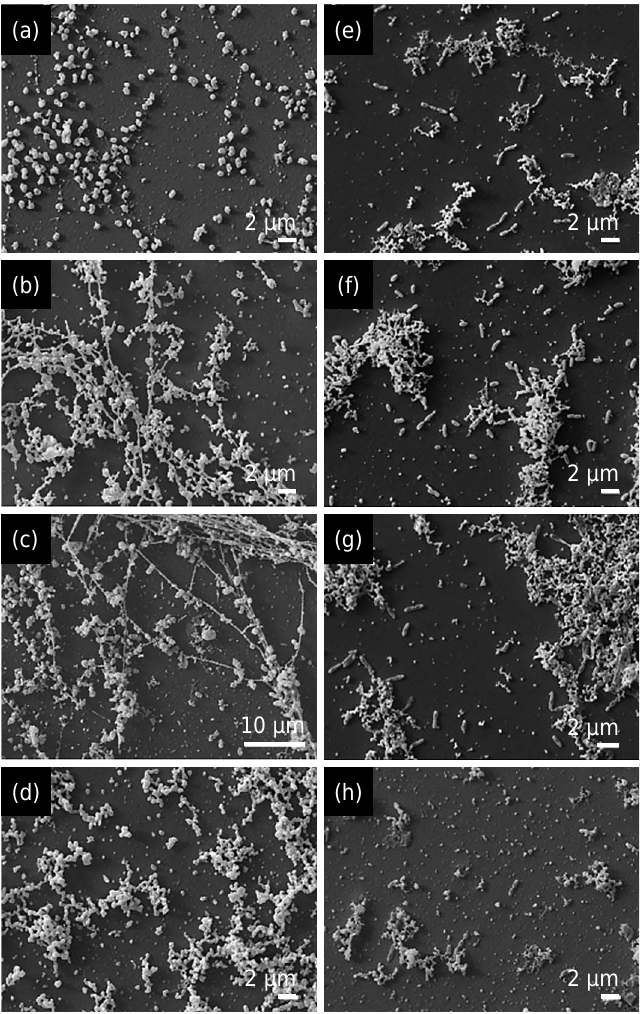
Figure 3. Scanning electron micrograph of the microbial biomass of the strains LMG 19424 T (a, b, c, and d) and UFLA 01-659 (e, f, g, and h) cultured in liquid LB medium in the following treatments: control – absence of metals (a and e), Cd at 1 mmol L -1 (b and f), Cu at 2 mmol L -1 (c and g), and Zn at 2 mmol L -1 (d and